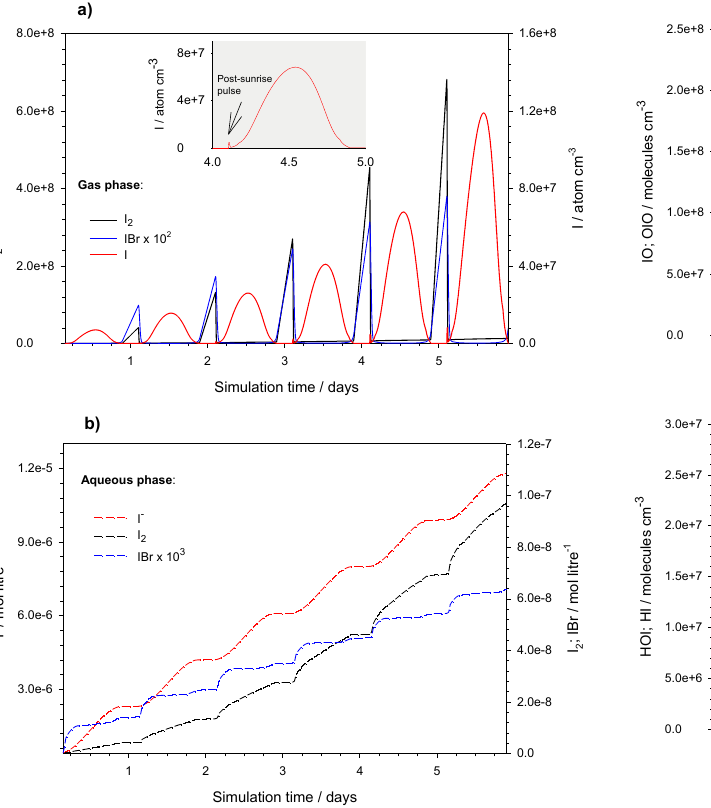
Figure 3. Iodine exchange from Antarctic sea ice to the atmospheric boundary layer. (a) Gas-phase I, I 2 , and IBr. (b) Aqueous I − , I 2 , and IBr in the BL. The post-sunrise pulse of I, shown in greater detail in the insert of Fig. 2a, is the result of the night-time build-up of atmospheric I 2 . Note that the emission of these species into the gas phase at night is slower than their production rates in the condensed phase. With time, the I − concentration becomes comparable to that of Br − and the reaction of HOI with I − , forming I 2 , and competes with HOBr+Br − (forming Br 2 ) . The differences in the I 2 ( aq ) and IBr ( aq ) concentration profiles are due to the fact that the reverse rate constant to form HOI + Br − , starting from IBr ( aq ) , is orders of magnitude faster than that for formation of HOI + I − , starting from I 2 ( aq ) (see Supplement). Note that this figure corresponds to a diffusion timescale ∼ 6 days ( D = 5 × 10 − 5 cm 2 s − 1 at ∼ 10cm and D = 1.3 × 10 − 4 cm 2 s − 1 at ∼ 12.5cm).